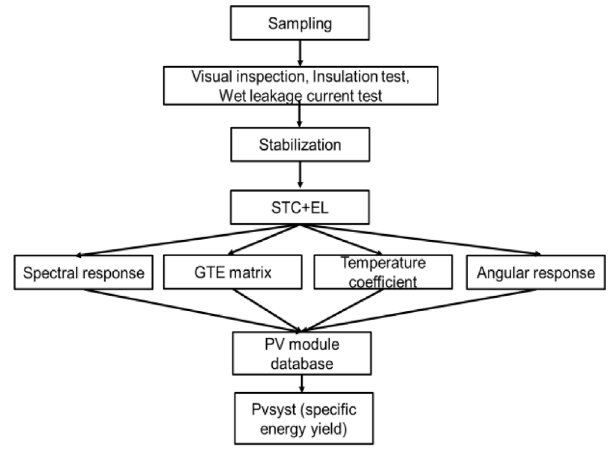
Fig. 1. The test and simulation fl ow used for calculation of